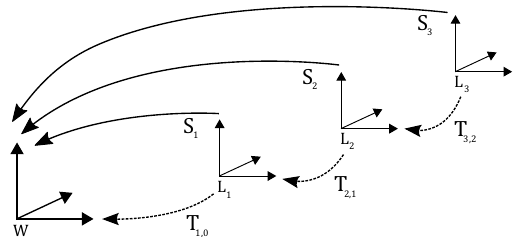
Figure 5. Overview of the problem statement. Each time a new point cloud P k has arrived, its sensor pose S k in relation to the world reference coordinate system W = L 0 is determined using the concatenation of the previous pose S k − 1 and the transformation T k , k − 1 .